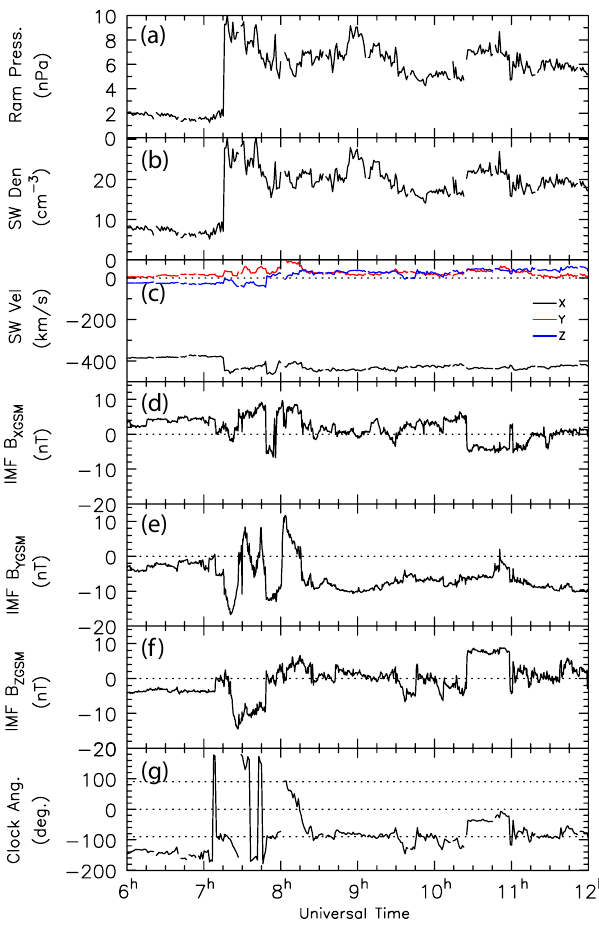
Fig. 4. Stack plot of solar wind and IMF data from ACE. The data have been lagged by 50min. Panel (a) shows the solar wind ram pressure. Panel (b) shows the ion density. Panel (c) shows the ion velocities in the X (black), Y (red) and Z (blue) directions. Panels (d–f) show the IMF B X , B Y , and B Z in GSM coordinates respectively. Panel (g) shows the IMF clock angle in degrees.